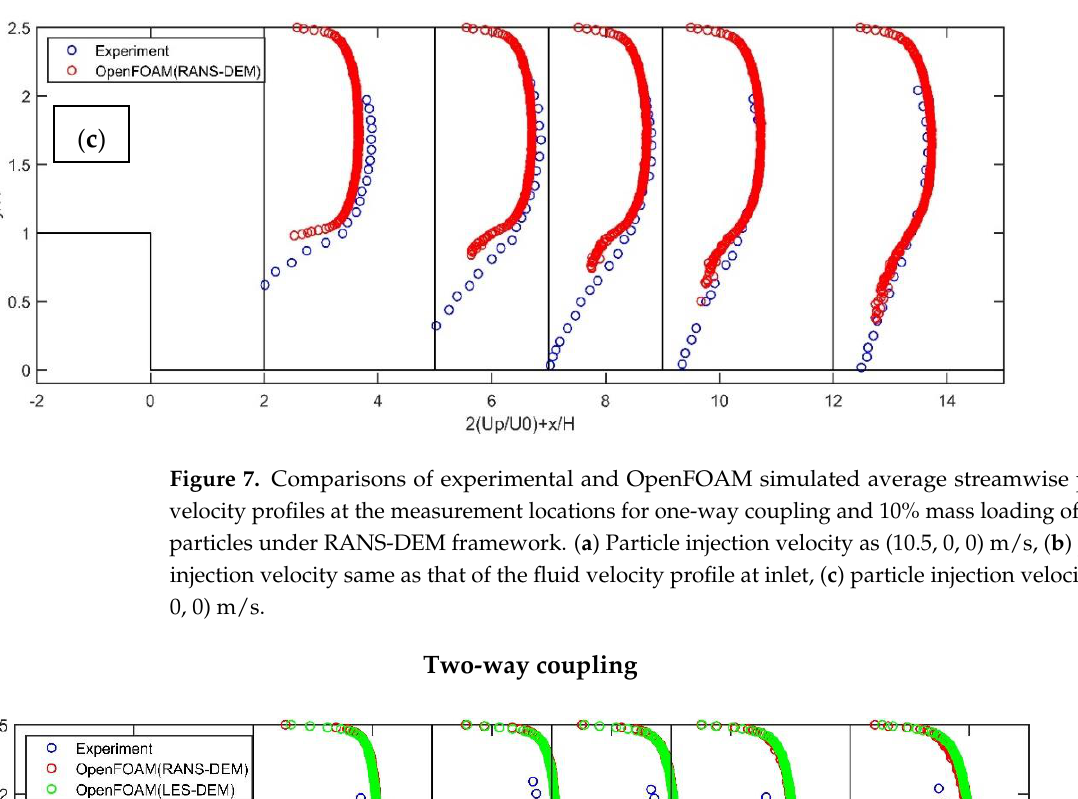
Figure 8. Comparisons of experimental and OpenFOAM simulated average streamwise particle ve- locity profiles at the measurement locations for two-way coupling and 10% mass loading of copper particles under RANS-DEM and LES-DEM frameworks. ( a ) Particle injection velocity as (10.5, 0, 0) m/s, ( b ) a particle injection velocity same as that of the fluid velocity profile at the inlet, ( c ) particle injection velocity as (0, 0, 0) m/s.